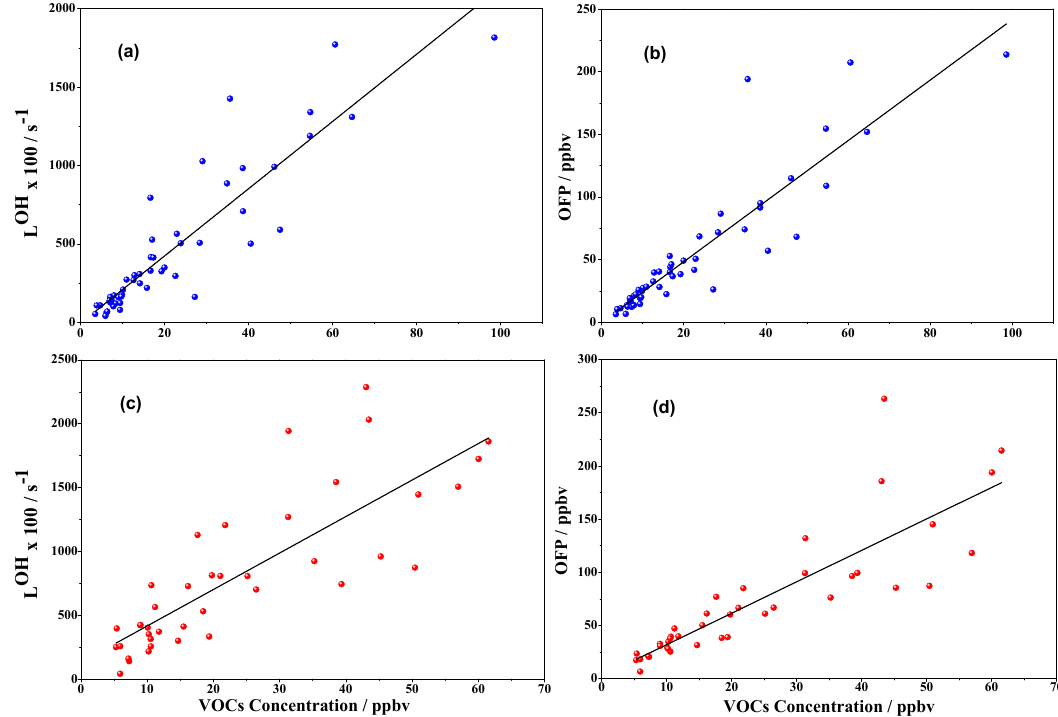
Figure 4. The relationship between the total L OH / OFP and TVOCs of the ( a , b ) observed and ( c , d ) initial VOCs for the sampling periods.